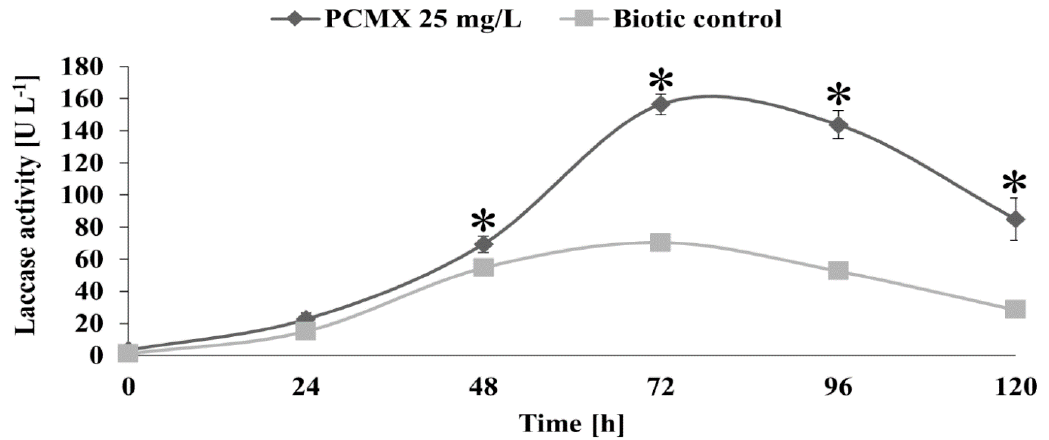
Figure 4. Laccase activity in T. versicolor cultures incubated with the addition of PCMX at a concentration of 25 mg L − 1 for 120 h. Each result represents an average ± SD ( n = 3). Statistical analysis was performed using the Mann–Whitney U test (* p < 0.05—a statistically significant increase in laccase activity relative to the control).